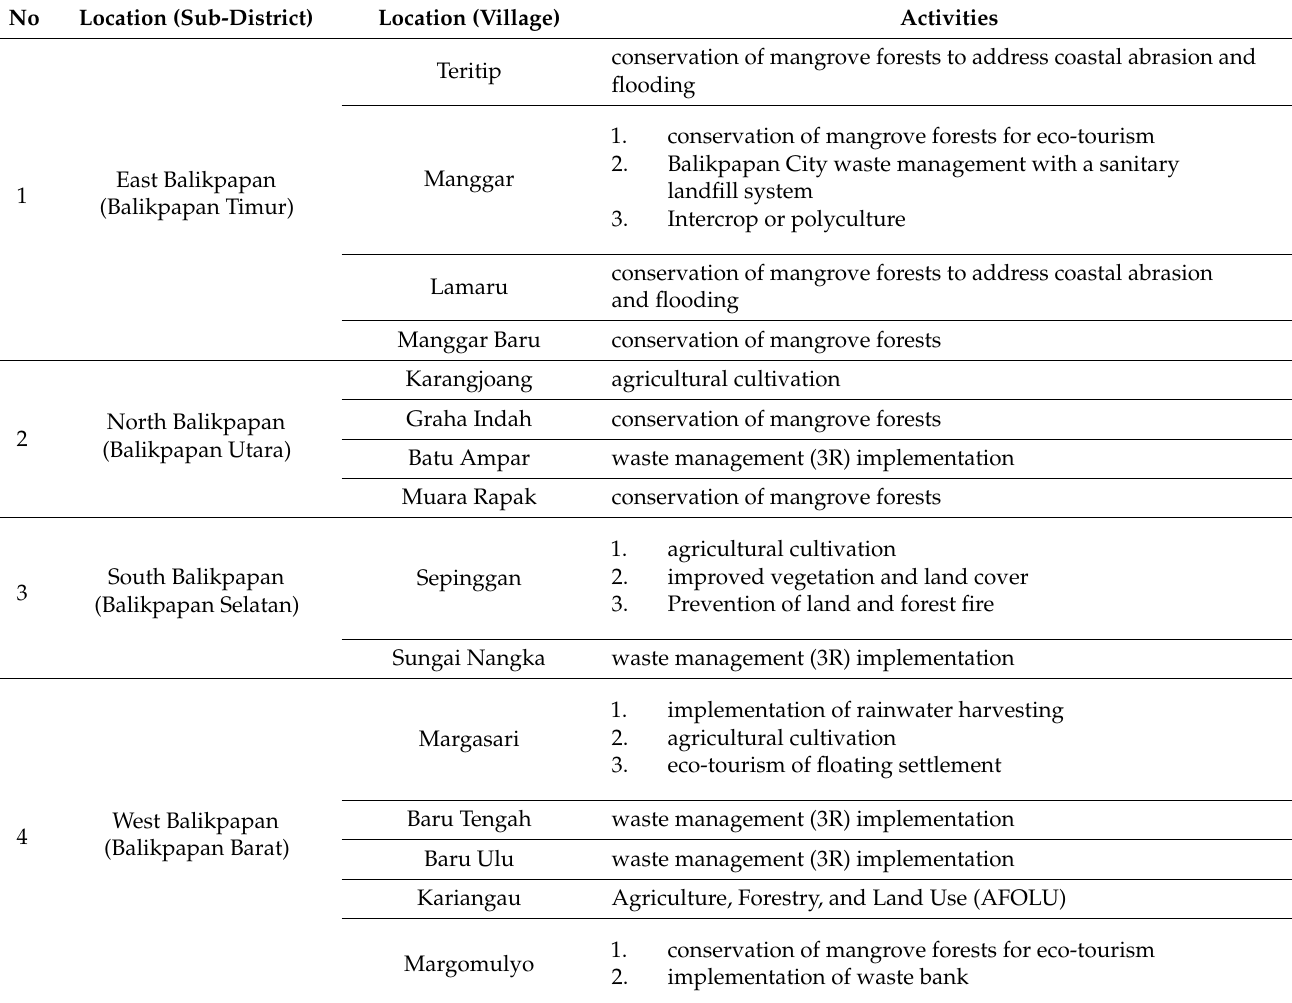
Table 1. Climate Village ( ProKlim ) Activities in Balikpapan City, Indonesia.